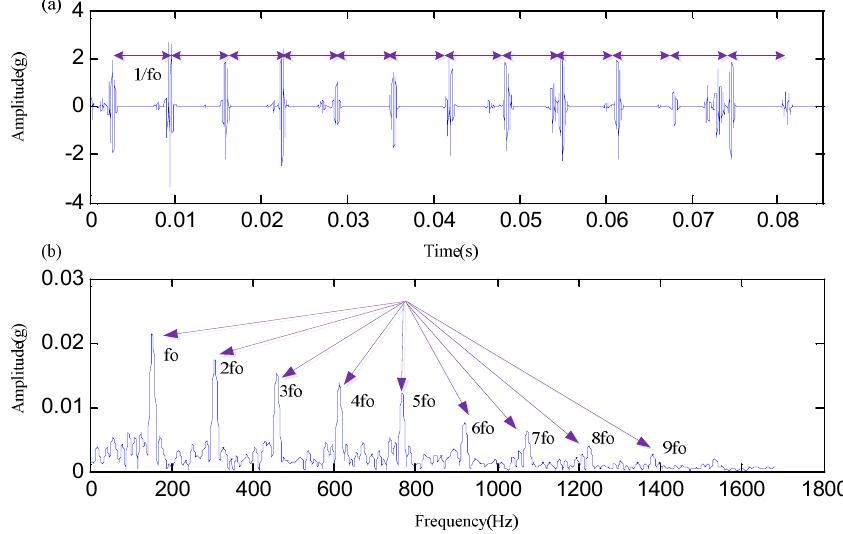
Figure 15. ( a ) De-noising signal by NSD. ( b ) Local envelope spectrum.